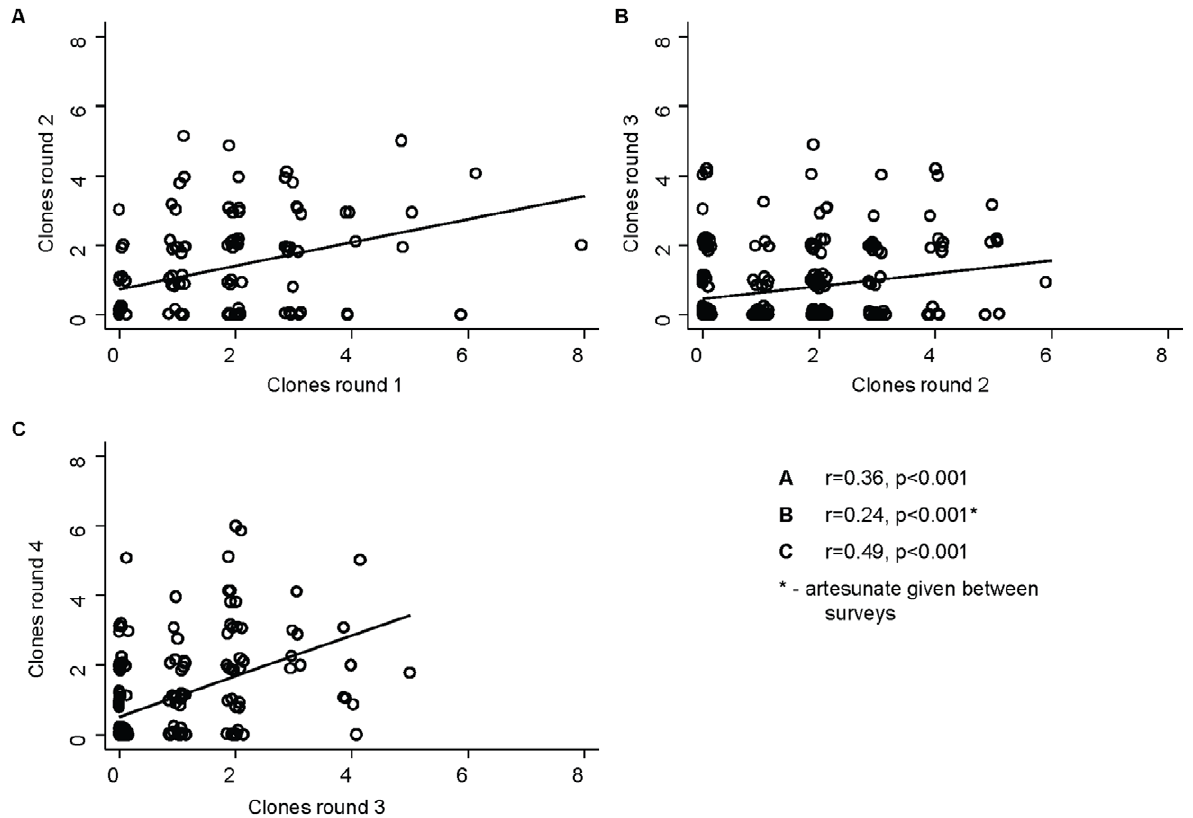
Figure 2. Intra-individual correlation in number of infecting clones between surveys without (A and C) and with treatment (B).